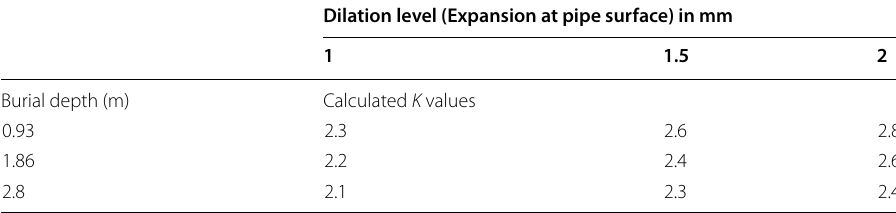
Table 5 Variation of K with burial depth [21] Dilation level (Expansion at pipe surface) in